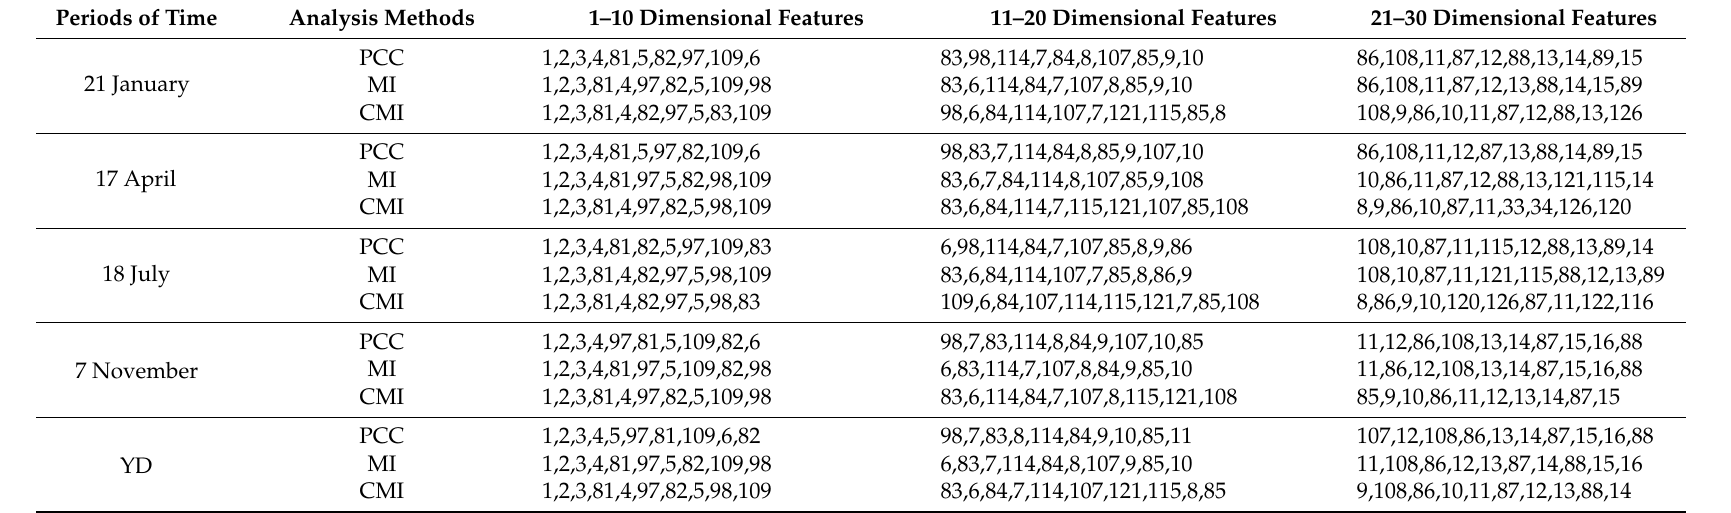
Table 4. Feature numbers of the most important 30